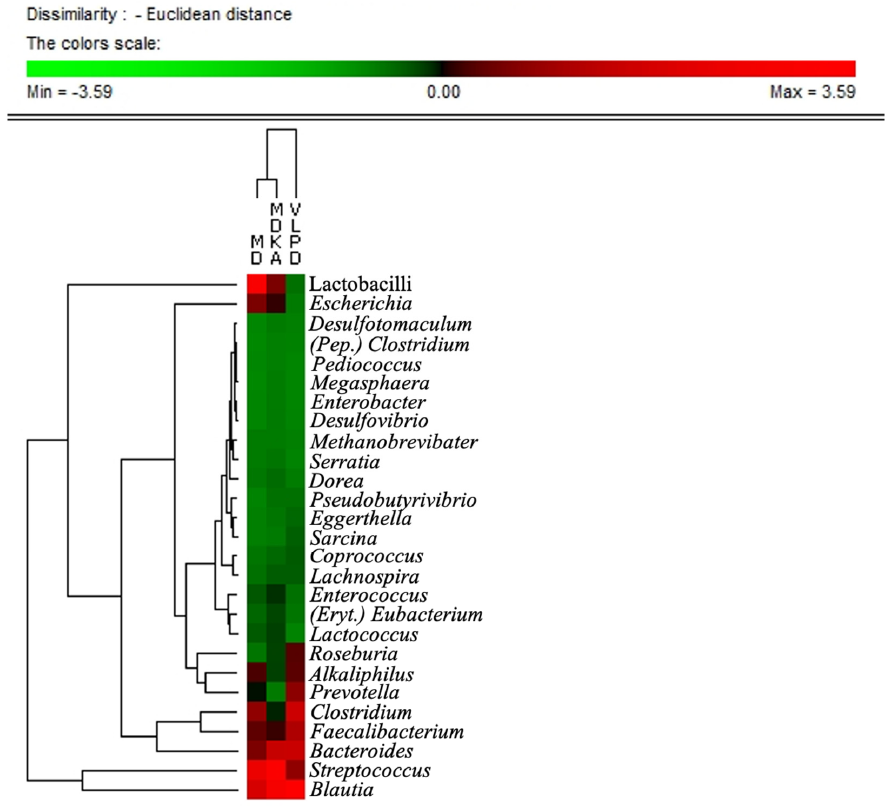
Figure 2. Fecal microbial genera found in chronic kidney disease (CKD) patients associated with different diets: Mediter- ranean diet (MD), ketoanalog-supplemented Mediterranean diet (MD + KA), and ketoanalog-supplemented very-low- protein diet (VLPD). Only statistical different ( p < 0.05) genera at least in one dietary regimen were reported. Eryt. - Eubacterium : genus Eubacterium belongs to the Erythrobacteraceae family; Pep. - Clostridium : genus Clostridium belongs to the Peptostreptococcaceae